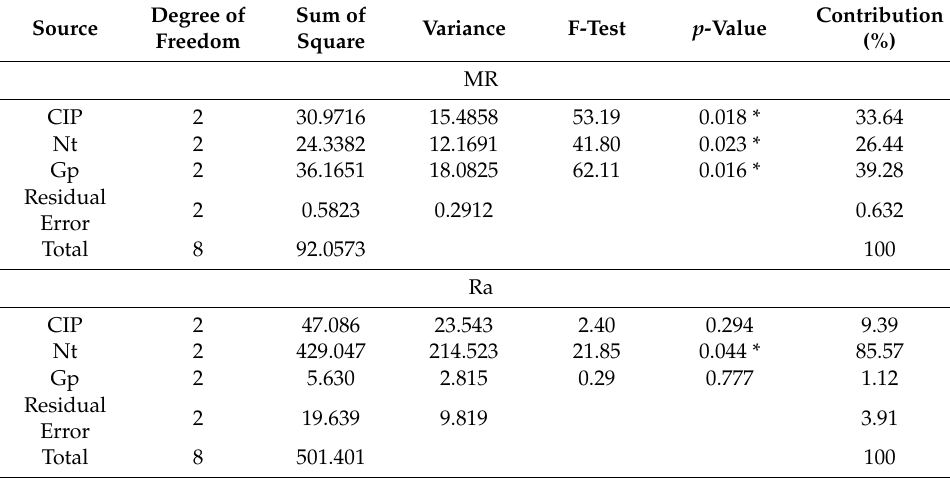
Table 4. ANOVA for S / N ratio for MR and